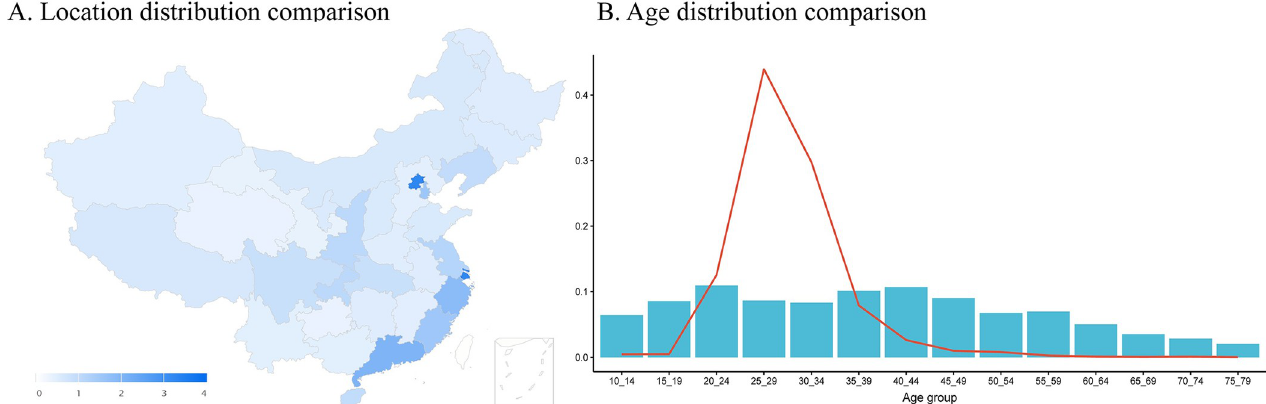
Fig 1. Comparison between Weibo user and Chinese 2010 census. Panel A (left) shows the oversampling rate for provinces in China. A more saturated color represents the larger ratio of relative proportion for each province of Weibo users comparing to that of the 2010 census data. Beijing (oversampling rate 6.53) and Shanghai (oversampling rate = 3.25) are the two most oversampled provinces, followed by provinces in the east of China. Panel B (right) shows the age distribution comparison. Blue bars represent census while red line depict Weibo users. Weibo users are more concentrated at a younger age range between 20– 40, indicating the disproportionate